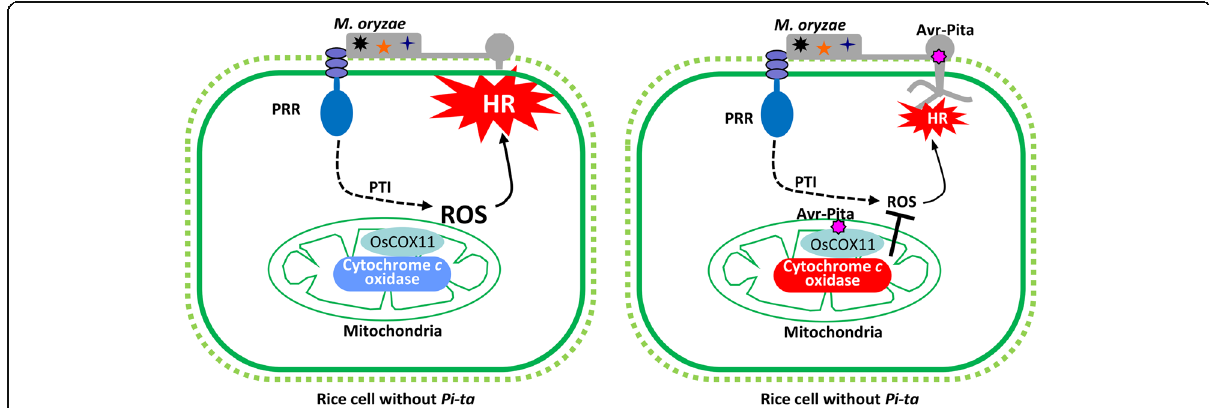
Fig. 7 A working model for the role of Avr-Pita in regulating defense responses in rice. The PRR on the rice plasma membrane perceives PAMP molecules from the fungal pathogen ( M. oryzae ) and activates PTI resulting in a ROS burst and HR to stop microbial invasion (left). In M. oryzae isolates carrying the effector Avr-Pita (right), this effector is secreted from M. oryzae and delivered into rice cells. There, Avr-Pita targets the host mitochondria and binds to OsCOX11 to promote COX activity, thereby decreasing ROS accumulation, resulting in reduced resistance to M.